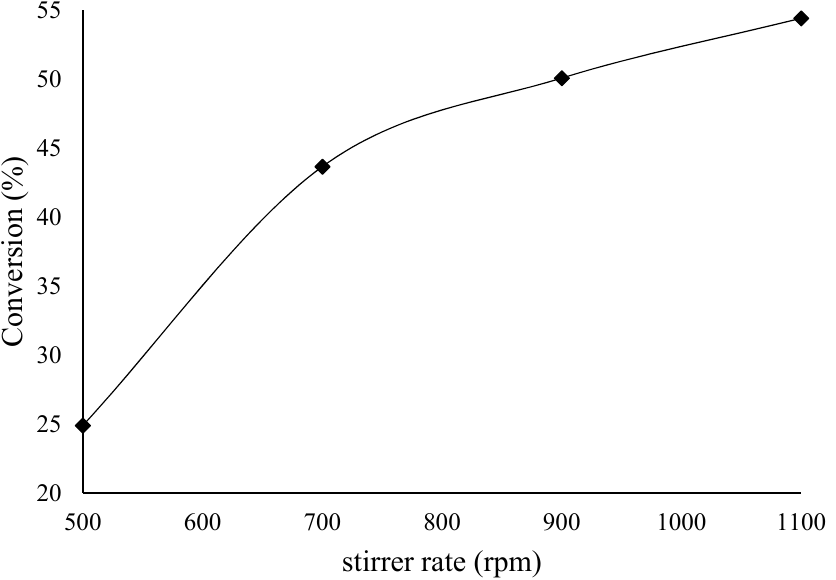
Figure 6. Effect of stirring speed on FA decomposition over 1%Ir:2%Pd/C. Reaction conditions: FA (0.5 M), catalyst (0.1 g; substrate:metal molar ratio = 137:1), and 240 min.